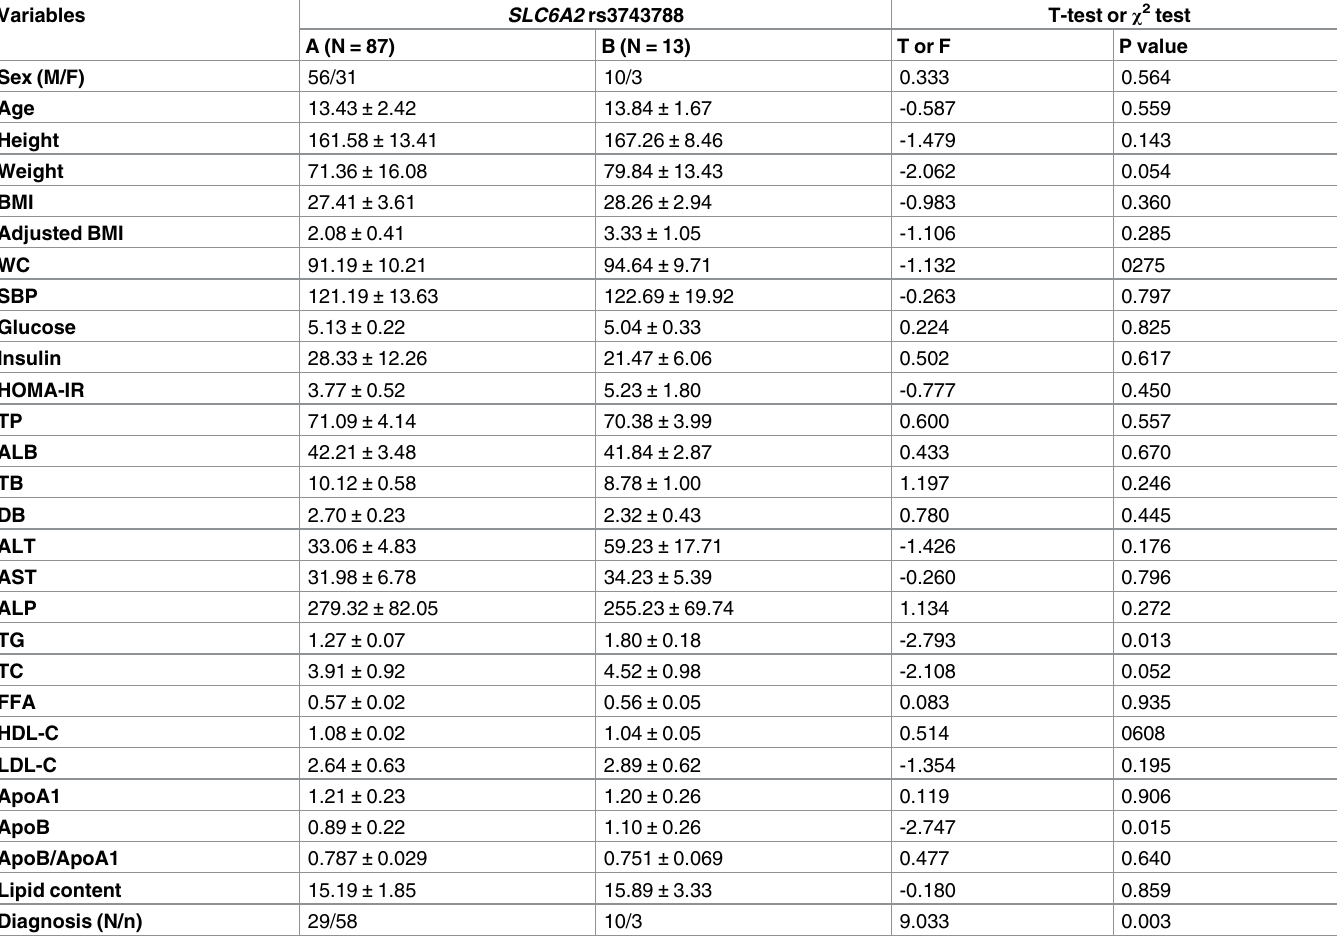
Table 4. The comparison of anthropometric and biochemical charactersbetween subjects with and without the SLC6A2 rs3743788 variant (sub- jects of Han Chinese ethnicity).